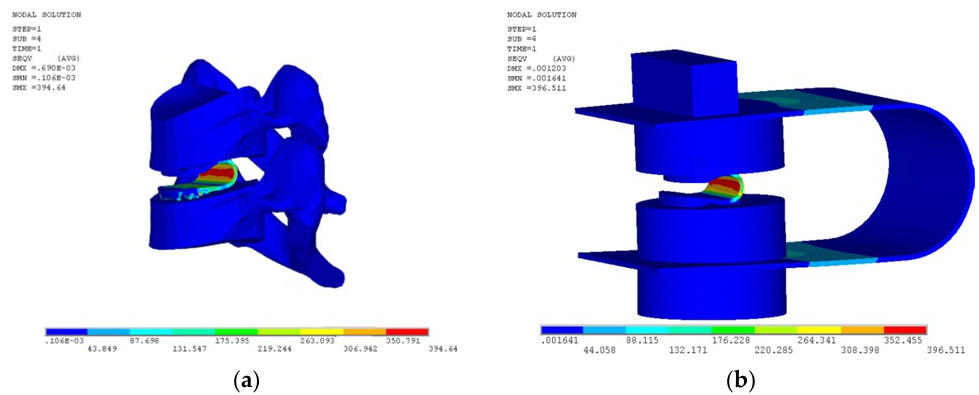
Figure 5. The contours of the equivalent stress of pure Ti DCI under the flexion condition: ( a ) within C5–C6 cervical spinal segments; ( b ) within the fatigue-testing fixture.